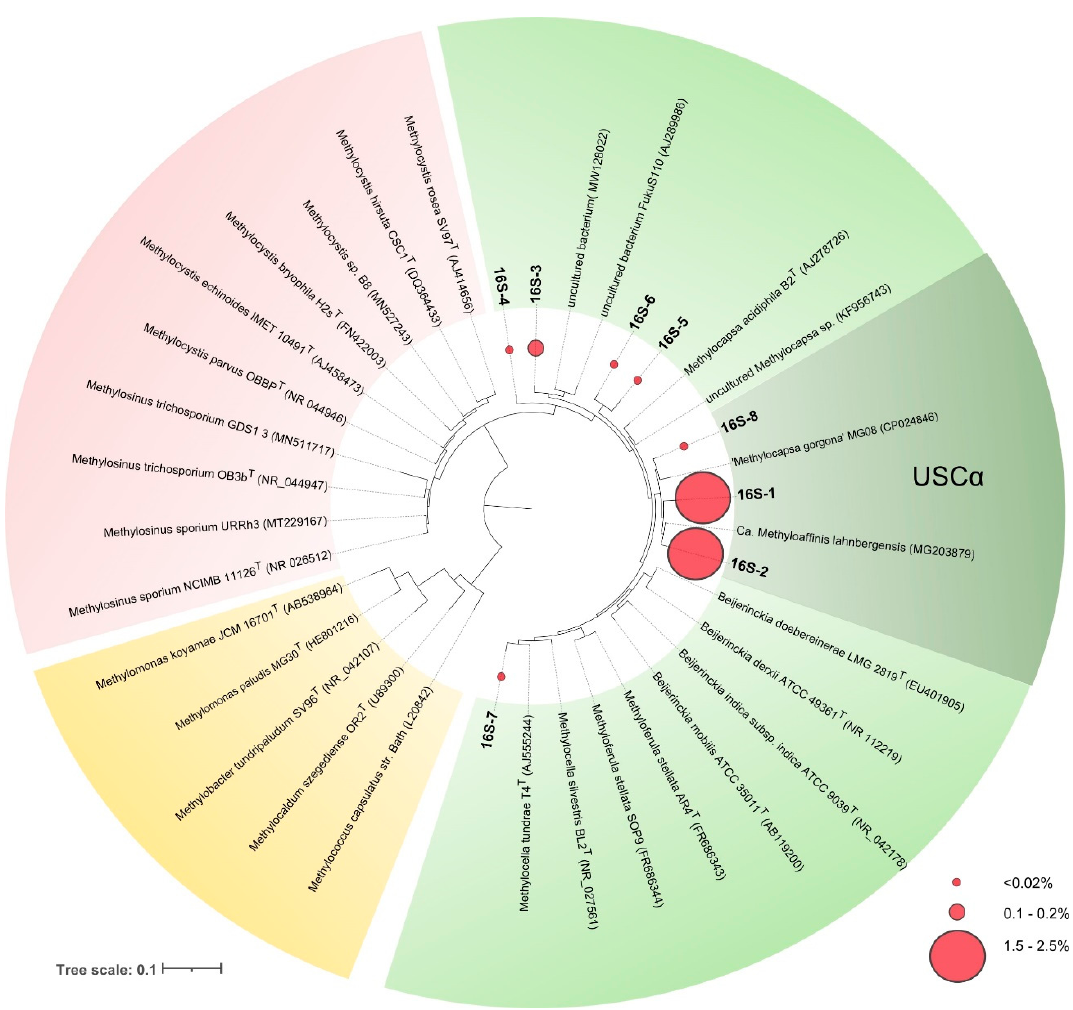
Figure 4. 16S rRNA gene-based maximum-likelihood tree showing the phylogenetic position of sequences retrieved from acidic tundra soil in relation to Candidatus Methyloaffinis lahnbergensis, “ Methylocapsa gorgon a” MG08 and some representatives of the family Beijerinckiaceae (shown in green), Methylocystaceae (red), and Methylococcaceae (yellow). Red circles of different sizes show relative abundances of the corresponding OTUs. The scale bar corresponds to 0.1 substitutions per nucleotide position .